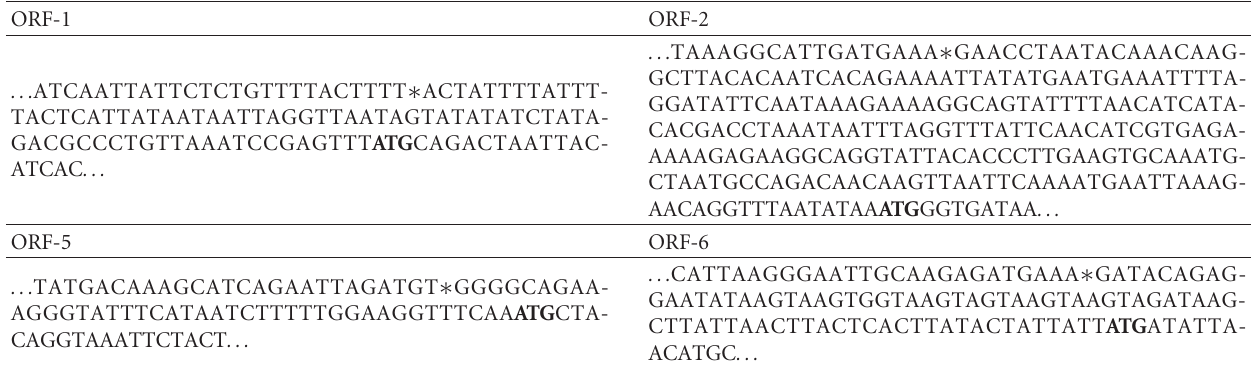
Table 3: Transcriptional start sites (TSS) of pPO1. ORFs identified by 5 (cid:3) RLM-RACE. The start codons of the ORFs are in bold, the TSS are preceded by an asterisk.